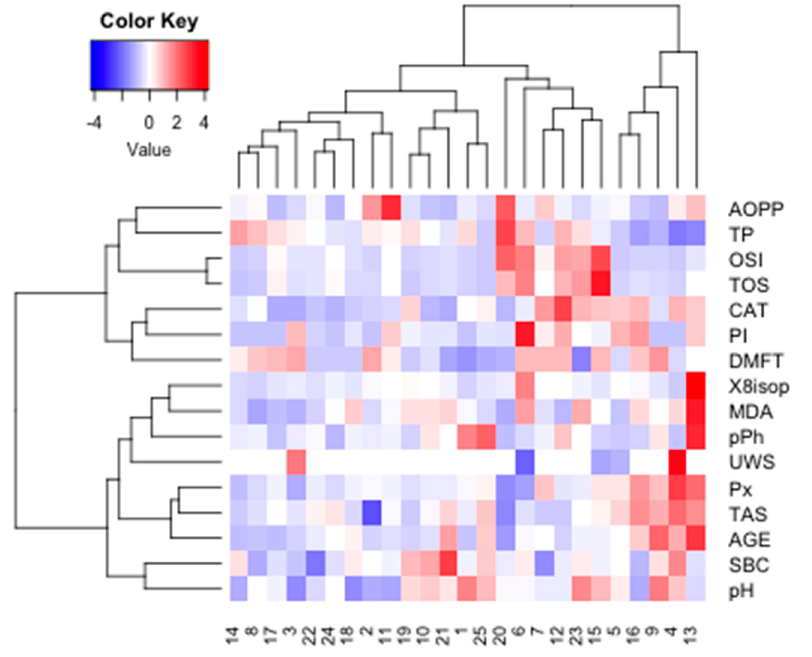
Figure 16. Cluster analysis for group NZ. NZ, generally healthy patients without the BRCA1 mutation. AOPP, advanced oxidation protein products; TP, total protein; OSI, oxidative stress index; TOS, total oxidant status; TAS, total antioxidant status; CAT, catalase activity; pPh, total phenolic content; Pl.I score, Plaque Index; DMFT, decay, missing, filled teeth; UWS, unstimulated whole saliva; SBC, salivary bu ff er capacity; 8-isop, concentration of 8-isoprostane; MDA, concentration of malondialdehyde; AGE, advanced glycation end-products; SBC, bu ff er capacity of saliva; Px, activity of salivary peroxidase.